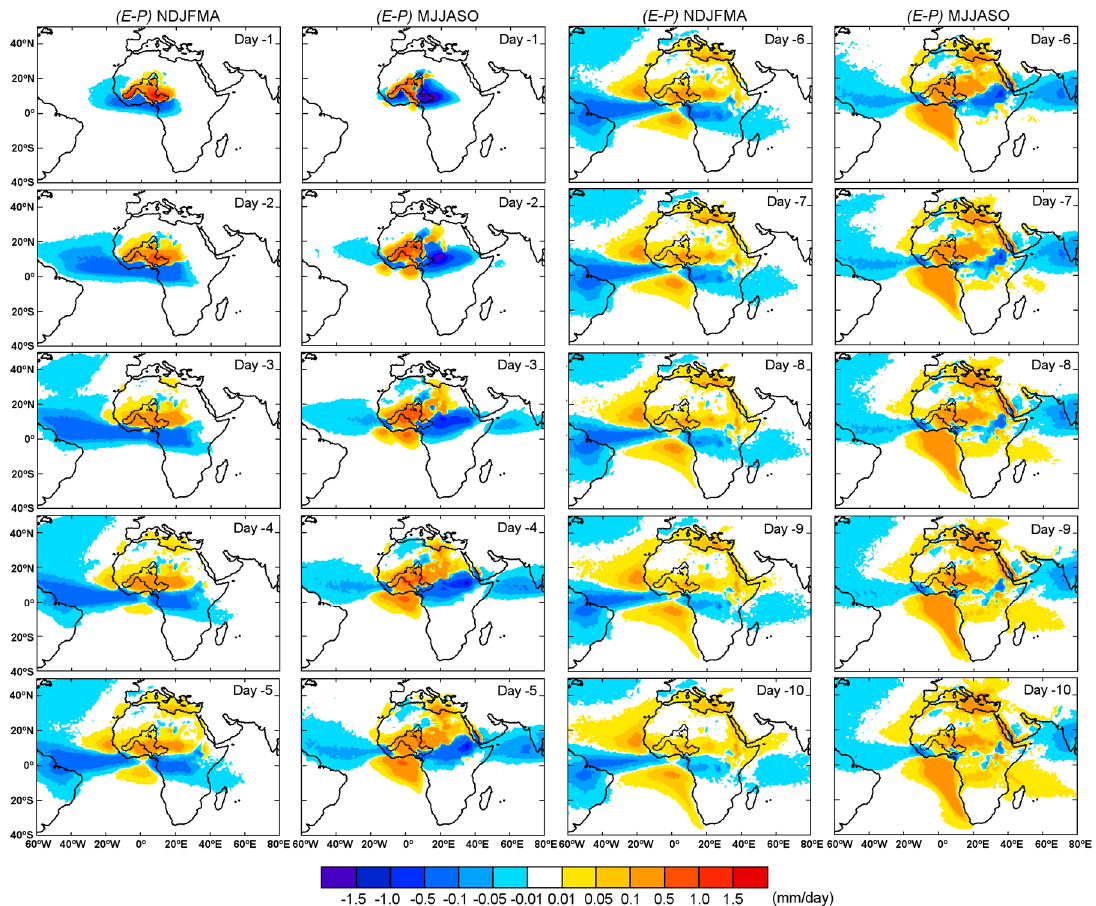
Figure 3. Seasonal pattern of (E – P) backward-integrated from the Niger River Basin for days − 1 to − 10, for dry (NDJFMA) and wet (MJJASO) seasons.